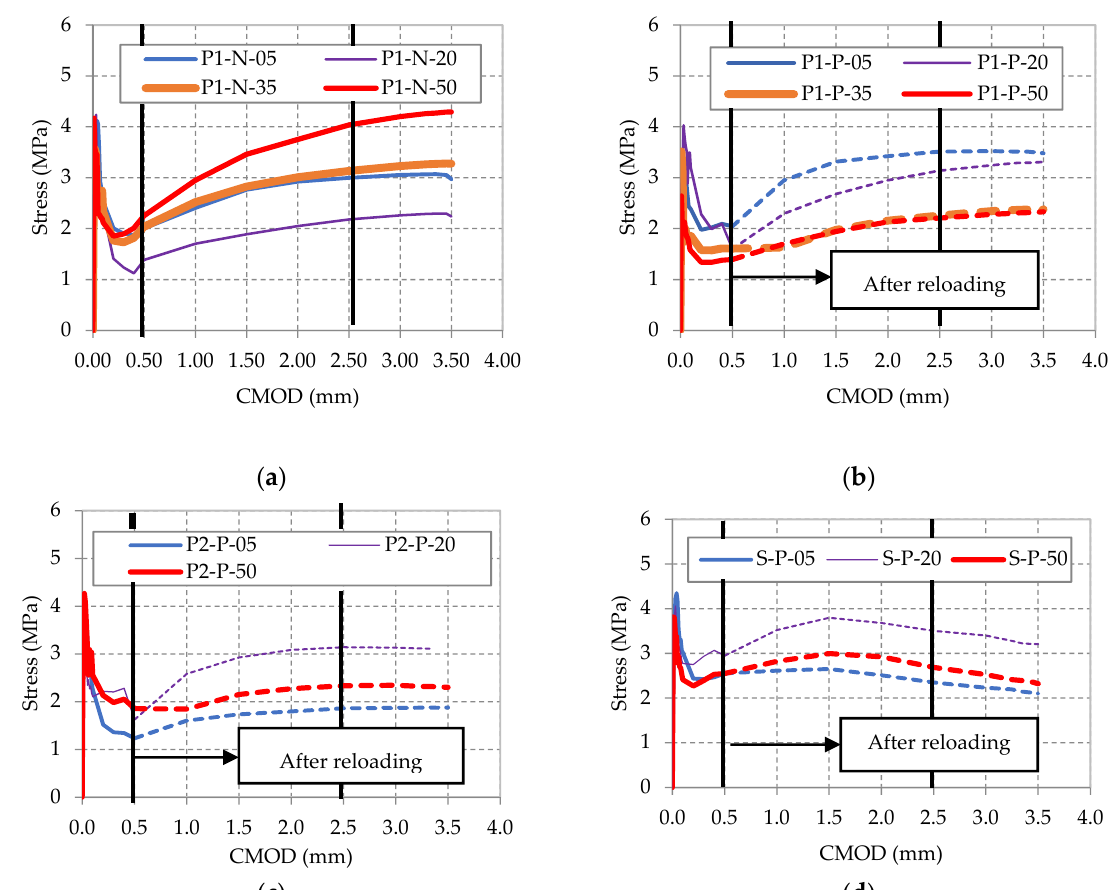
Figure 7. Stress-CMOD curves at different temperatures for each FRC reinforced with: ( a ) P1 (uncracked state), ( b ) P1 (pre-cracked state), ( c ) P2 (pre-cracked state) and ( d ) S (pre-cracked state).